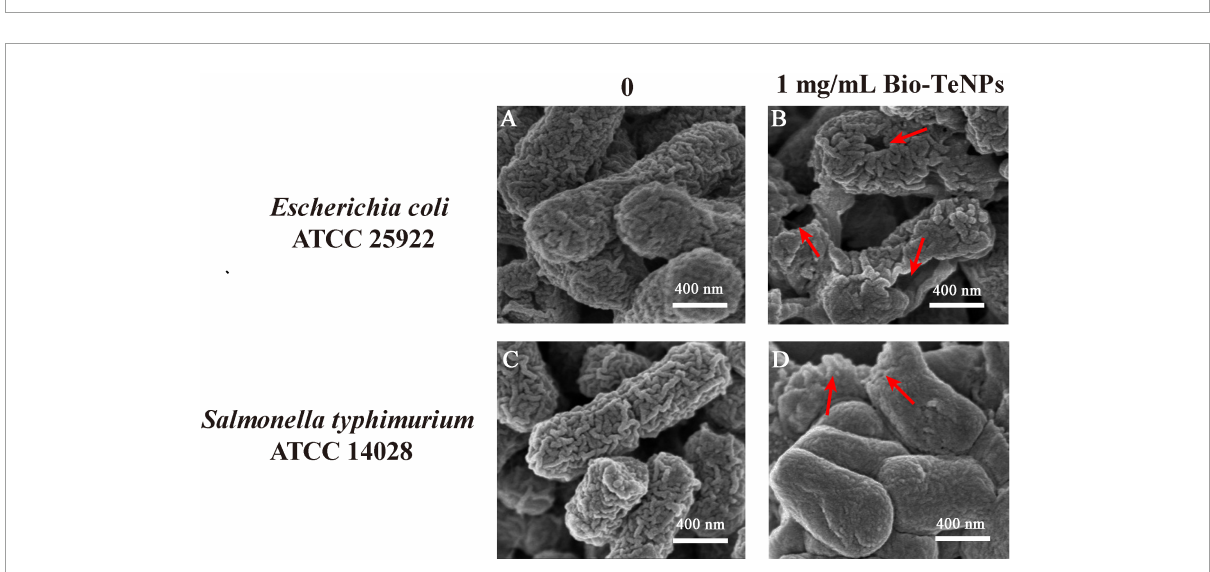
FIGURE8 Morphological observation of E . coli and S . typhimurium cells. SEM image of E . coli with 0 (A) and 1 mg/mL Bio-TeNPs (B) . SEM image of S . typhimurium with 0 (C) and 1 mg/mL Bio-TeNPs (D)